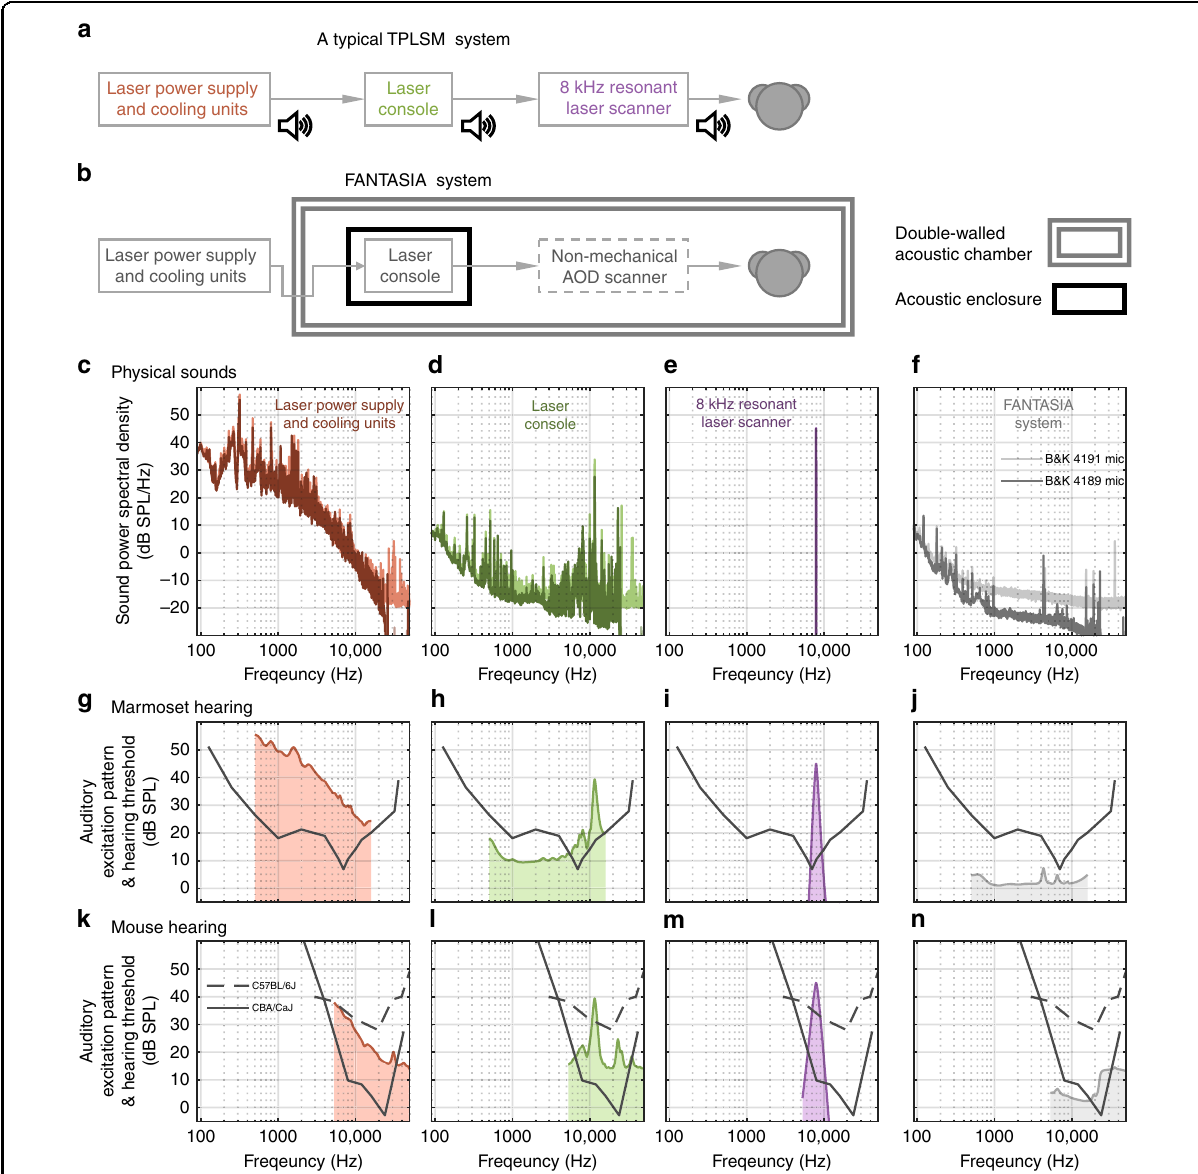
Fig. 1 Acoustic noises of TPLSM systems. a An illustration of major sound-generating components in a typical TPLSM system. b The strategies for eliminating two-photon imaging sounds in our FANTASIA system. c – f The acoustic power spectral densities of imaging noises. These noises include the sounds from several components of a typical TPLSM system ( c – e ) and the operating noise of our FANTASIA system ( f ). Each sound was measured twice by two different calibration microphones (B&K 4189 with a standard spectral range and a low noise fl oor; B&K 4191 with an extended spectral range and an elevated noise fl oor). g – j The auditory excitation patterns are generated from the noises in ( c – f ). These excitation patterns are estimated in marmoset monkeys, with the marmoset hearing threshold 17 also plotted as a reference (black solid curve). k – n The mouse auditory excitation patterns are generated from the noises in ( c – f ), with the hearing thresholds of both CBA/CaJ strain 25 and C57BL/6J strain 33 also plotted as references (solid and dashed black